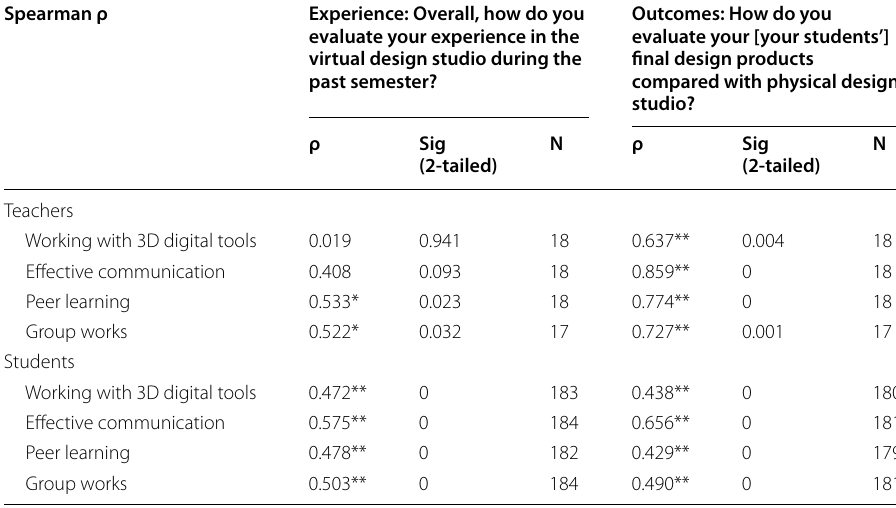
**Correlation is significant at the 0.01 level (2-tailed) *Correlation is significant at the 0.05 level (2-tailed)